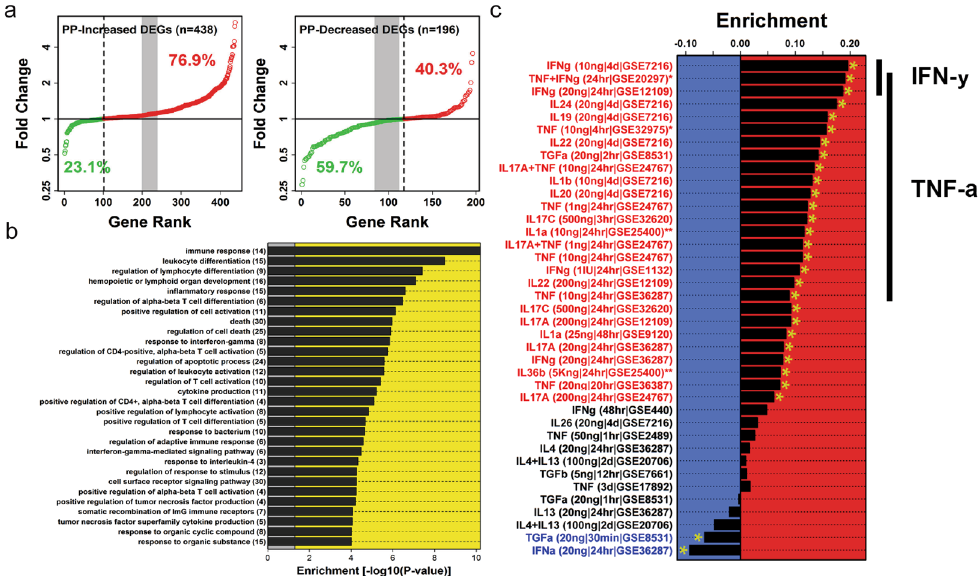
Figure 1. Psoriasis and atherosclerosis have overlapping gene expression and biologic processes. ( a ) Using a systems biology approach, we compared global transcriptome datasets of psoriasis skin (n = 216 to post- mortem samples of carotid atherosclerotic plaque (n = 13 early stage; n = 16 advanced stage) and determined 76.9% of increased DEGs and 59.7% of decreased DEGs are observed in both tissues. ( b ) Further analysis utilizing Gene Ontology biological process categories demonstrated that 66 Gene Ontology biological processes are enriched in both psoriatic and advanced atherosclerotic plaque (top 30 shown, p < 0.0001), and correspond to immunological processes such as inflammatory response, response to IFN- γ , regulation of T cell activation and antimicrobial responses. The number of increased genes associated with each GO term is listed in parentheses. ( c ) Keratinocytes were then systematically stimulated with combinations of cytokines enriched in both psoriasis and atherosclerotic lesions determined by RNAseq. Positive statistics denote enrichment for genes induced by a given cytokine treatment, while negative statistics denote enrichment for genes repressed by a given cytokine treatment. Black bars on left highlight IFN- γ and TNF enriched